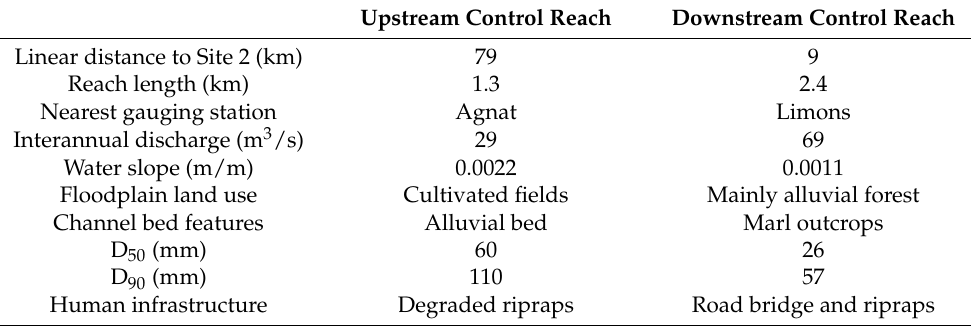
Table 3. Main geomorphological and hydrological characteristics of two control reaches upstream and downstream of Site